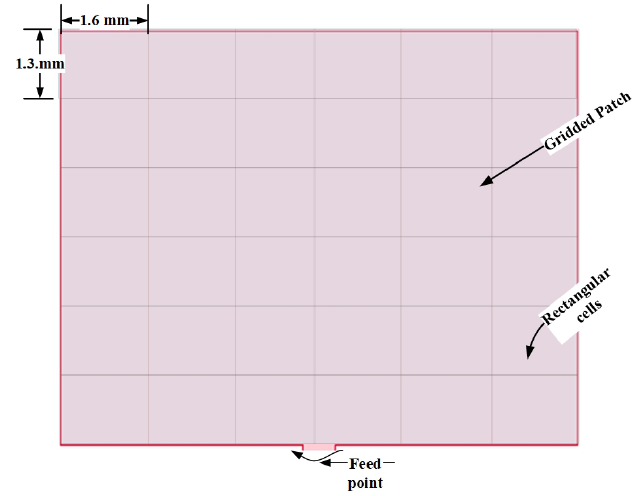
Figure 3. Placement of 36 rectangular cells on a rectangular patch